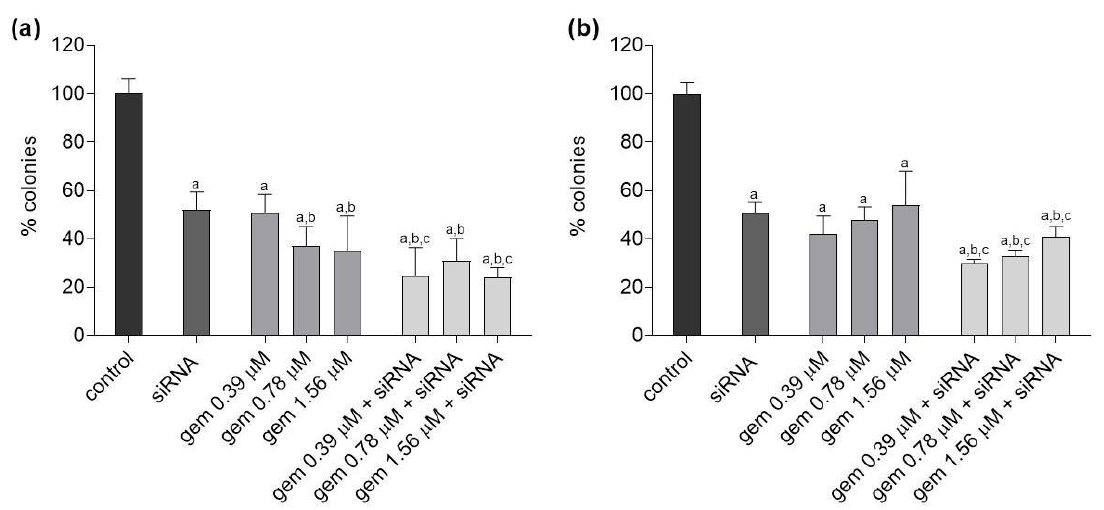
Figure 4. Percentages of J82 ( a ) and UM-UC-3 ( b ) colonies after treatment with gemcitabine, siRNA JHDM1D-AS1 , or gemcitabine combined with siRNA JHDM1D-AS1 . Control: untreated cells; gem: gemcitabine. a: p < 0.05 compared to control; b: p < 0.05 compared to siRNA; c: p < 0.05 compared to respective gemcitabine concentration